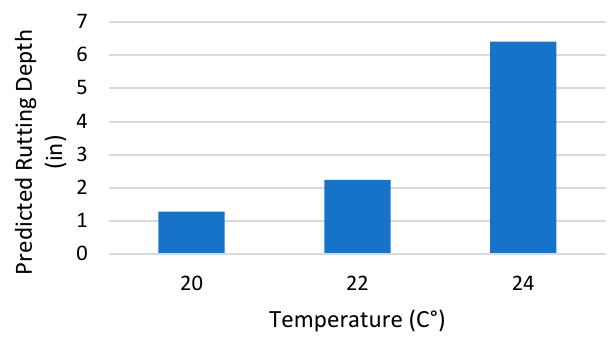
Figure 9. Model sensitivity for Temperature.